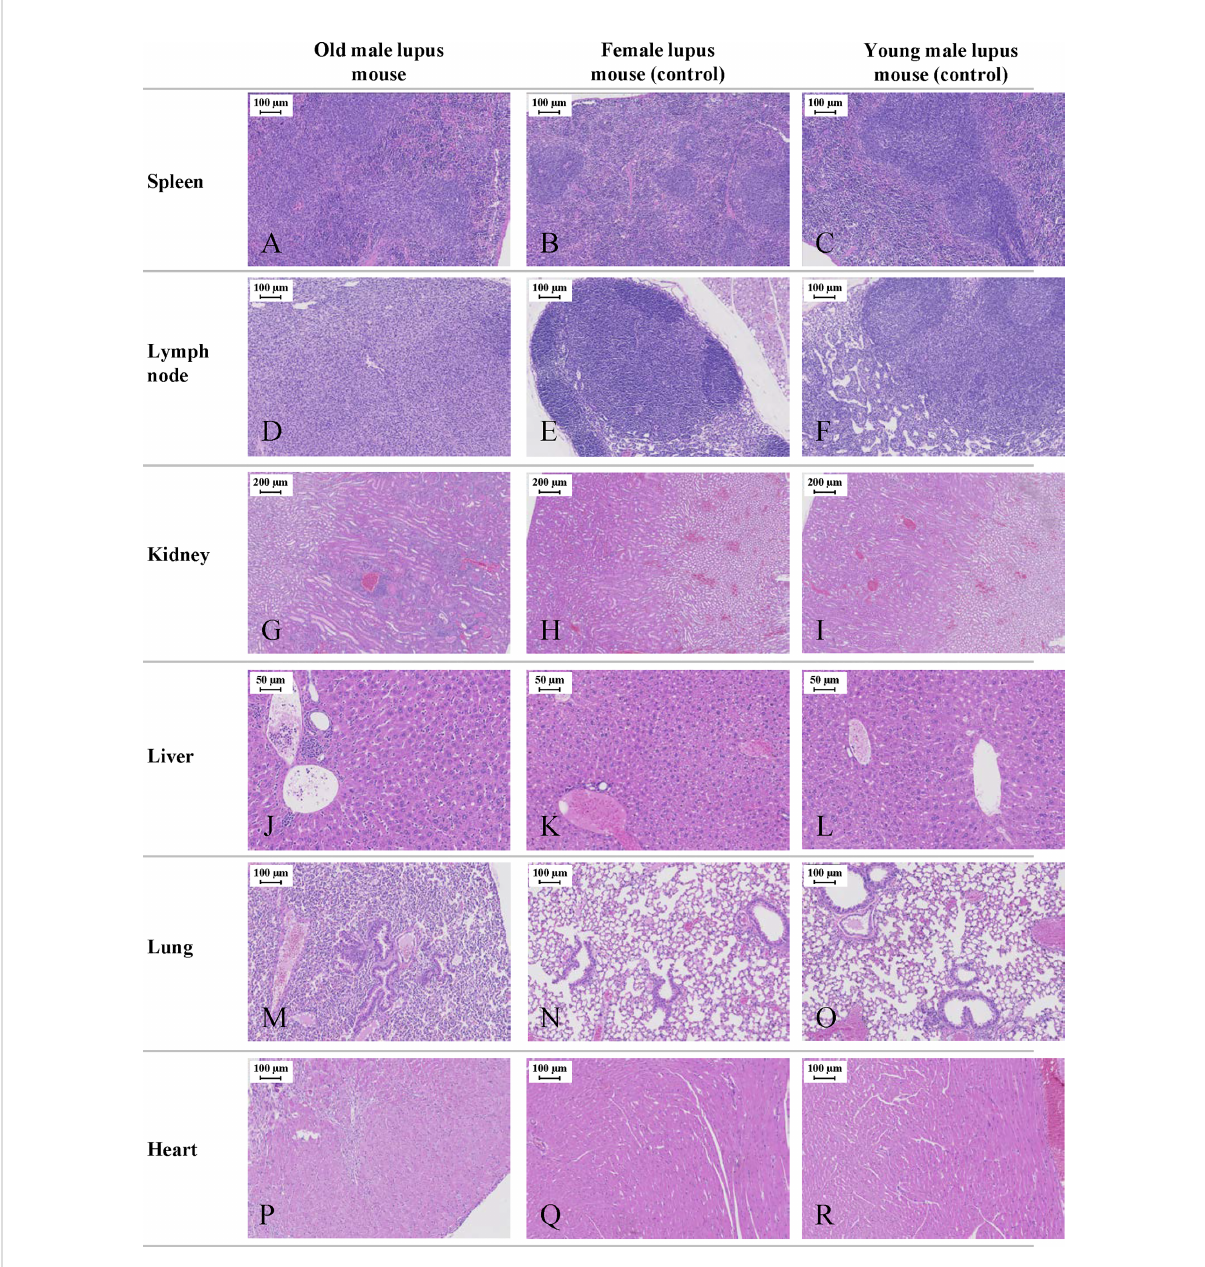
FIGURE 5 Representative histological images of the NZW/LacJ x BXSB/MpJ 9 F1 lupus mice. Internal organs (spleen, lymph nodes, kidneys, liver, lungs, and heart) were examined in 16-week-old male and female mice, and in young/healthy male mice (8 weeks). Young males without disease and female mice served as controls. Old lupus male mice showed abnormalities in multiple organs. Mild to moderate diffuse splenic lymphoid proliferation (A) compared to female (B) and young male lupus mice (C) . Marked lymphadenopathy with diffuse cortical and medullary lymphoid hyperplasia in multiple lymph nodes of old male (D) versus histologically normal lymph node architecture in female (E) and young male mice (F) . Moderate chronic multi-focal to segmental glomerulointerstitial nephritis (G) compared to unaffected female (H) and young male (I) mice. Moderate multifocal sinusoidal and periportal in fl ammatory cell in fi ltrates in the liver of old male animals (J) . Histologically normal liver from female (K) and young male (L) mice. Lung section from old male mice with pulmonary interstitial hypertrophy, intra-alveolar macrophages, and bronchiolar epithelial hyperplasia (M) . Histologically unremarkable lung sections from female (N) and young male mice (O) . Ventricular myocardium from old male mouse with moderate single cell to multifocal necrosis and mild to moderate multifocal myocarditis (P) . Normal ventricular myocardium in female (Q) and young male (R) mice. All sections stained with